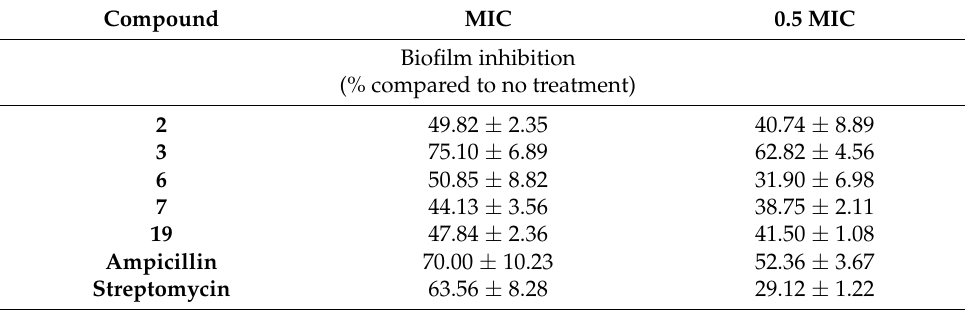
Table 4. Effect of selected compounds on P. aeruginosa biofilm